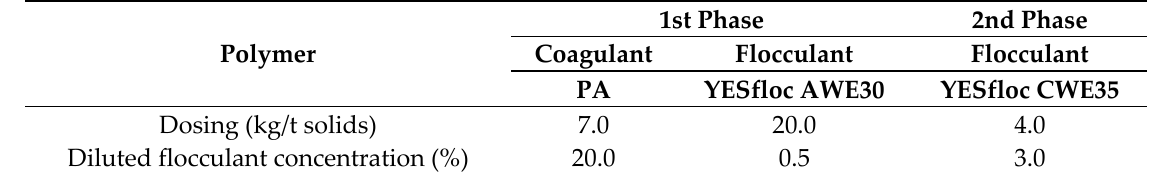
Table 3. Laboratory flocculation test result